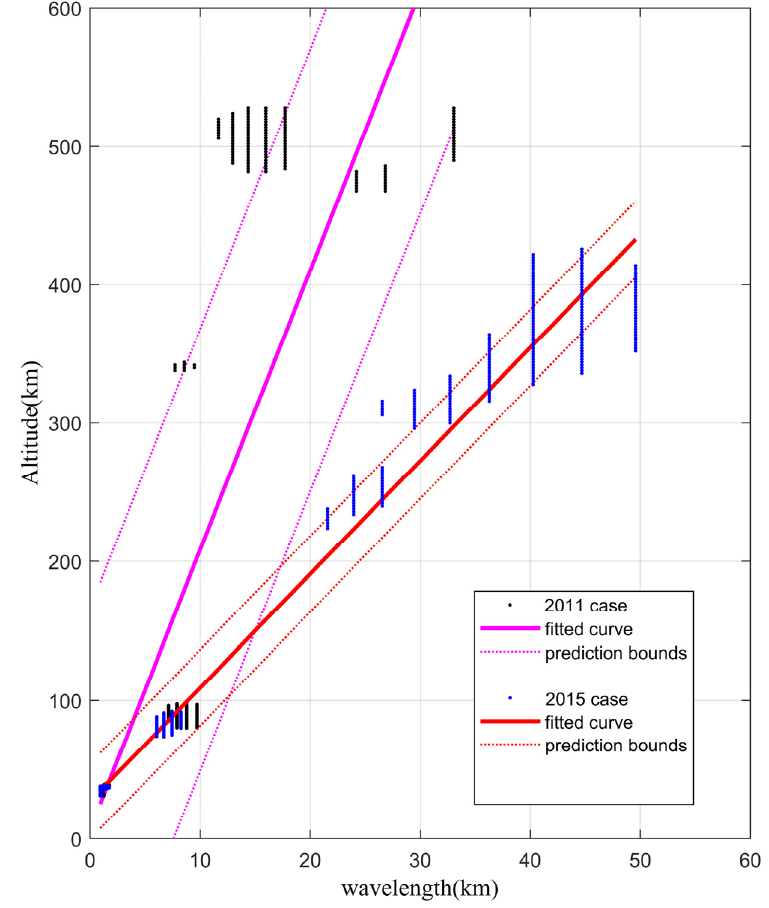
Figure 9. The observed vertical perturbation scales (blue dots mark the 2015 case and black dots mark the 2011 case) and the fitted curve (red line marks the 2015 case and pink line marks the 2011 case) with 95% confidence bounds (dashed lines).